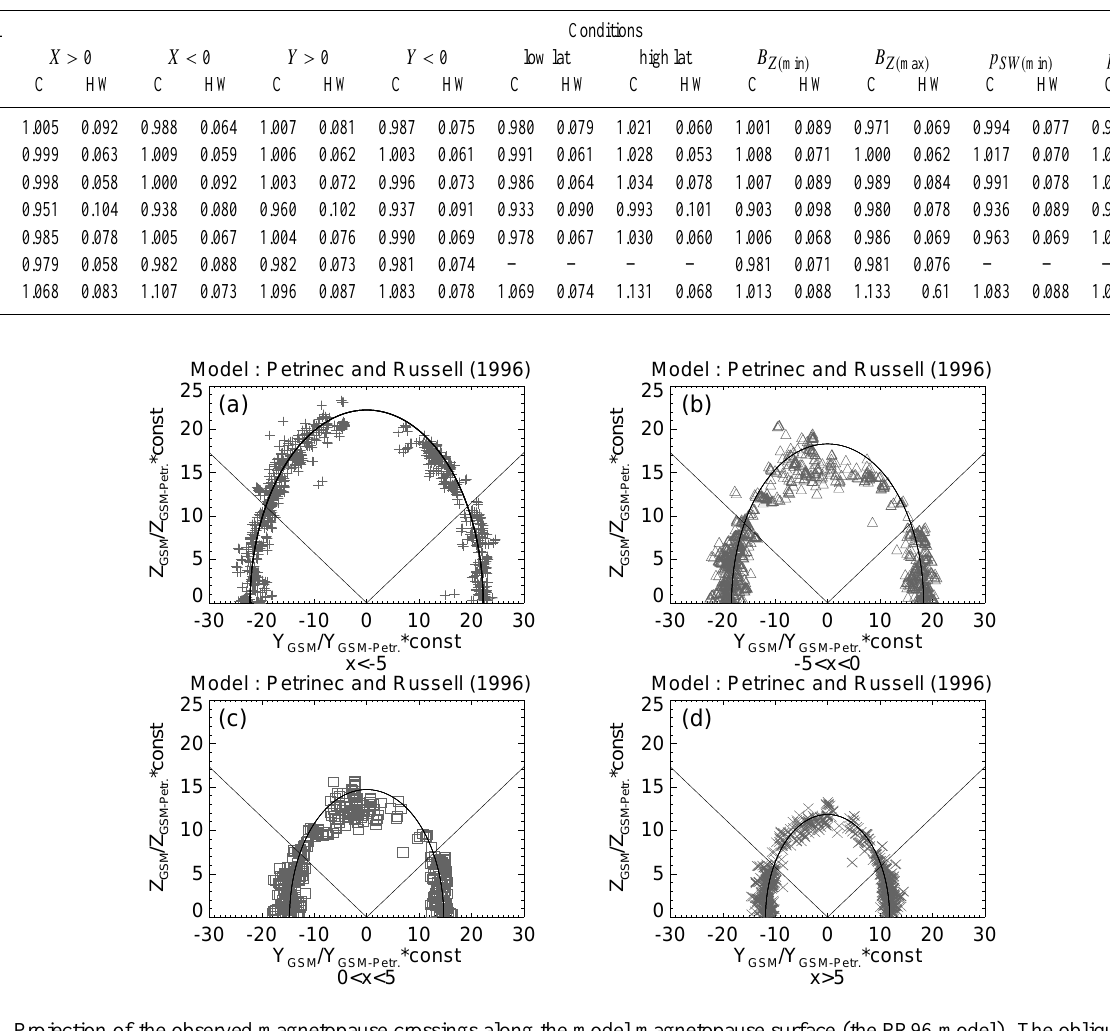
Fig. 7. Projection of the observed magnetopause crossings along the model magnetopause surface (the PR96 model). The oblique straight lines indicate 30 ◦ of geomagnetic latitude. This angle is used as a breakpoint between low- and high-latitudes.